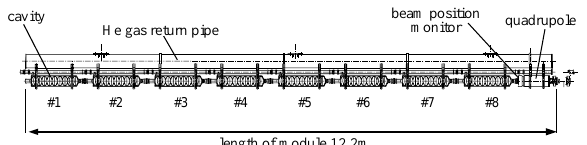
FIG. 4. Cryogenic module of the TESLA Test Facility linac comprising eight 9-cell cavities and a superconducting quadrupole.